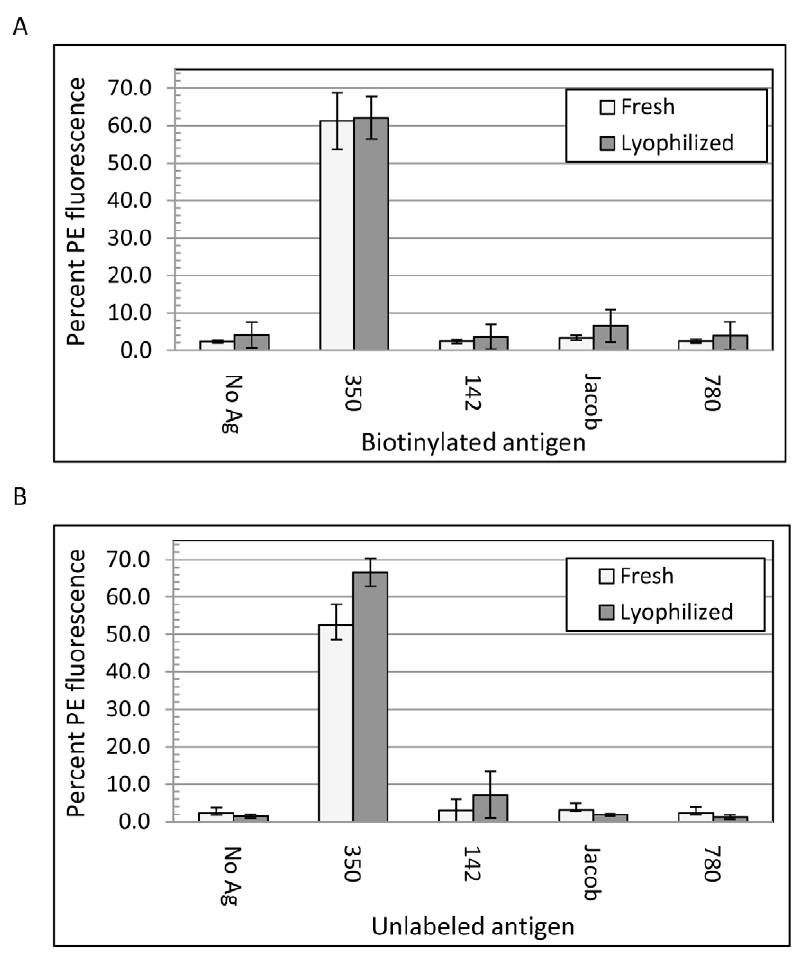
Figure 2. Pre- and post-lyophilization antigen binding and specificity of clone 350-E2 . Fresh, non-lyophilized 350-E2 yeast and lyophilized, rehydrated 350-E2 yeast were split into 10 aliquots. In Panel A, each aliquot received either no antigen, or 100 nM each of 350, 142, Jacob, or 780. Biotinylated antigens were used in every case, and antigen binding was detected by incubating with SA-PE. Panel B was performed as in Panel A, except that non-biotinylated antigens were used and antigen binding was detected by incubation with rabbit-anti-350 antiserum followed by GaR- PE. The percent of PE-positive yeast was determined by gating the PE fluorescence relative to the ‘‘no antigen’’ control. Values are means of three experiments plus or minus the standard deviation. The light grey bars indicate binding of the fresh yeast to each antigen, and the dark grey bars indicate binding of the lyophilized yeast to the antigens.